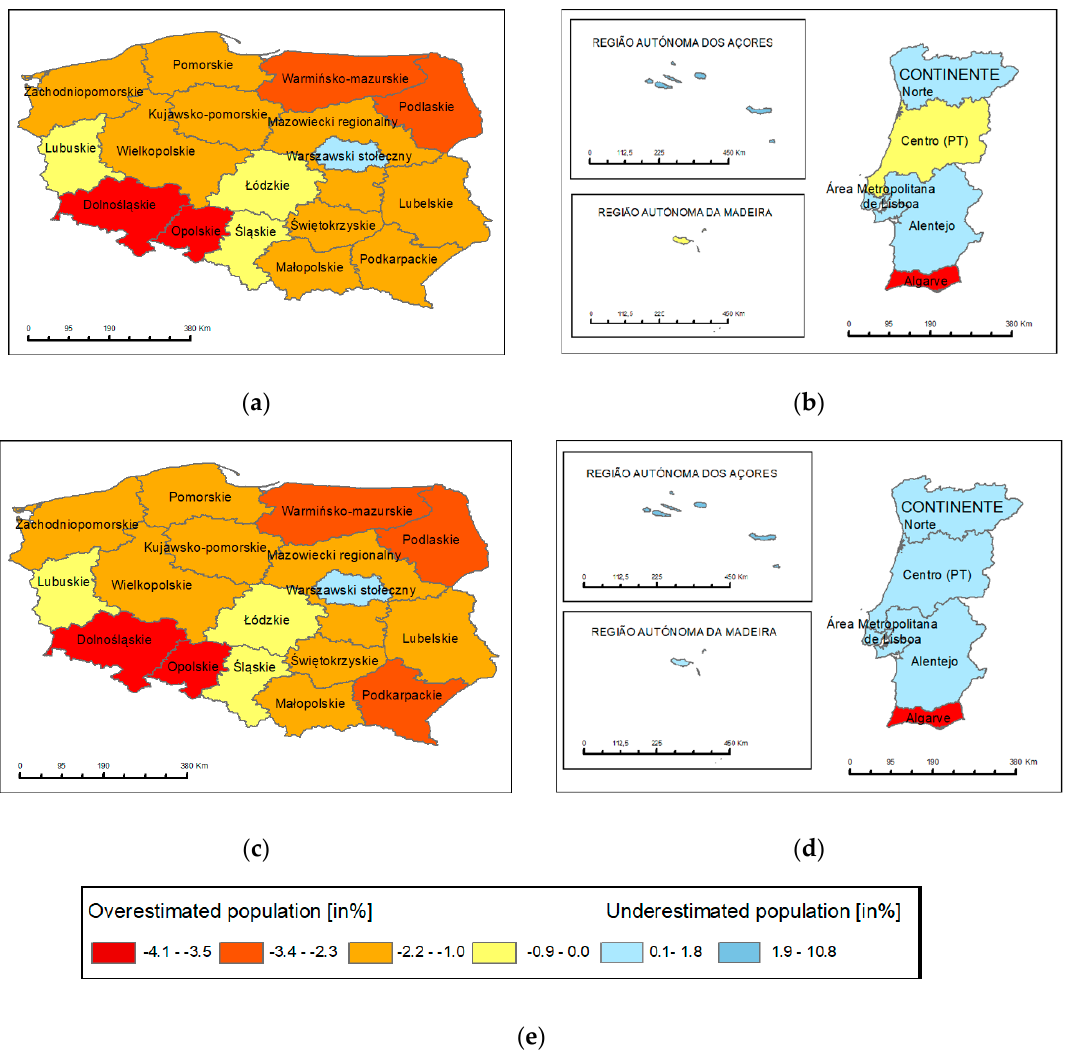
Figure 8. NUTS 2: MAPE. ( a ) GHS-POP 250 m, Poland; ( b ) GHS-POP 250 m, Portugal; ( c ) GHS-POP 1 km, Poland; ( d ) GHS-POP 1 km, Portugal; ( e ) map legend.